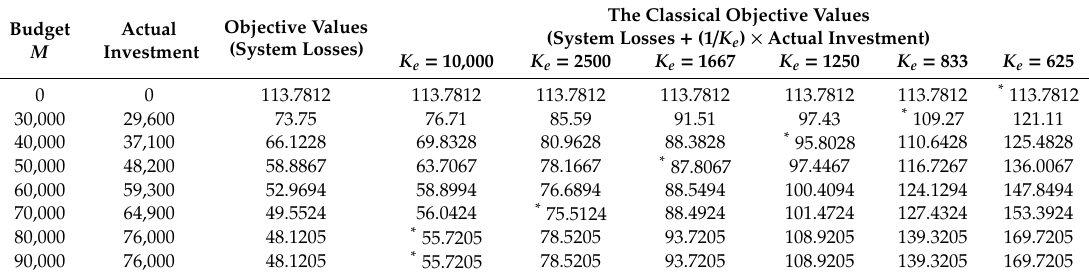
“ ∗ ” represents the optimal design of classical goal function.